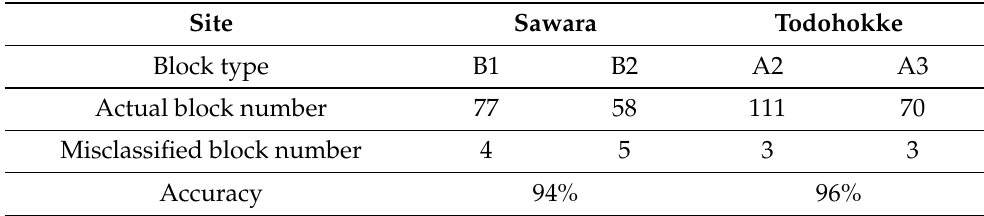
Figure 17. Visualization of pose estimation on UAV data ( a ) and MBES data ( b ) of Todohokke port. The first column is the measured point cloud. The block models are transformed to the scene space using pose results and displayed in the middle column. The last column is a visualization of the average fitting error of the pose estimates, where red points indicate that its distance from the nearest block model is larger than 100 mm. Table 6. Accuracy of block-type